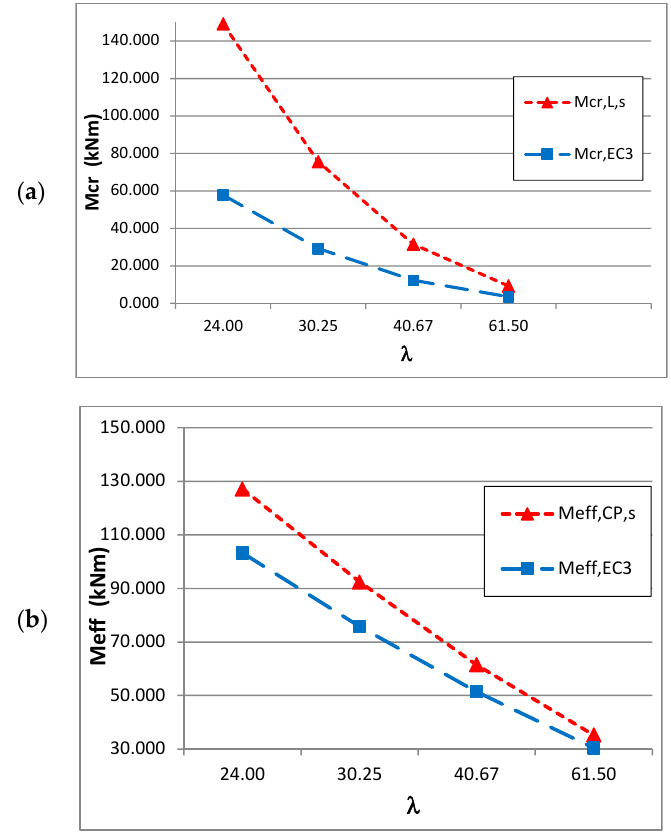
Figure 11. Graphs of ( a ) M cr , s and ( b ) M ef f as a function of slenderness λ CP .